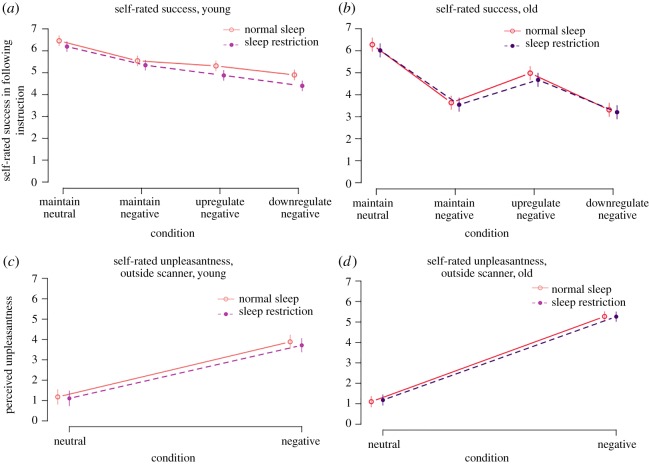
(a) Rated success in following the instructions. Younger and older participants behaved quite differently in the scanner. In young participants, sleep restriction caused a significant decrease in rated success for maintain neutral, downregulate and upregulate negative. Dots represent means and vertical lines 95% CI. (b) Rated unpleasantness. In younger participants, sleep restriction caused a borderline significant effect on ratings of unpleasantness in a subsample.